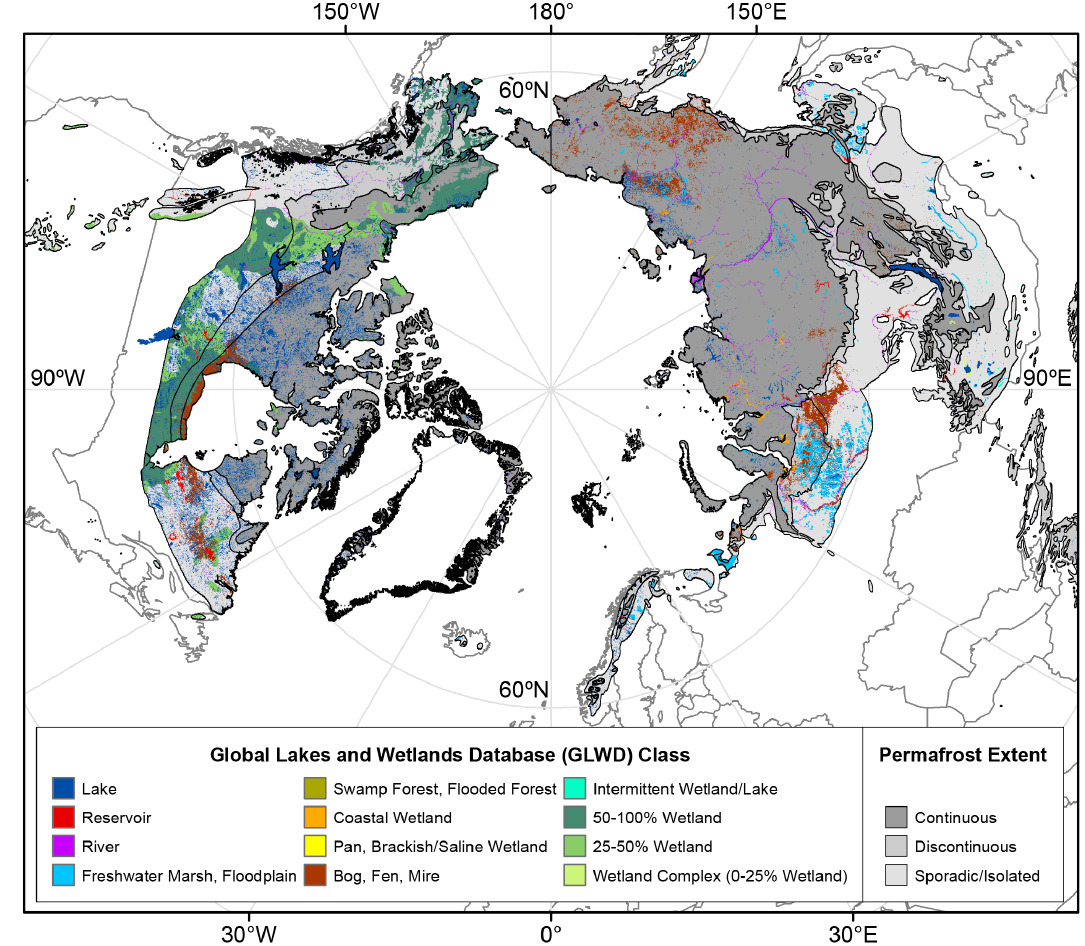
Figure 1. Map of the permafrost zones in the Northern Hemisphere (greyscale; Brown et al., 1998) superimposed on water bodies from the Global Lakes and Wetlands Database (Lehner and Döll,